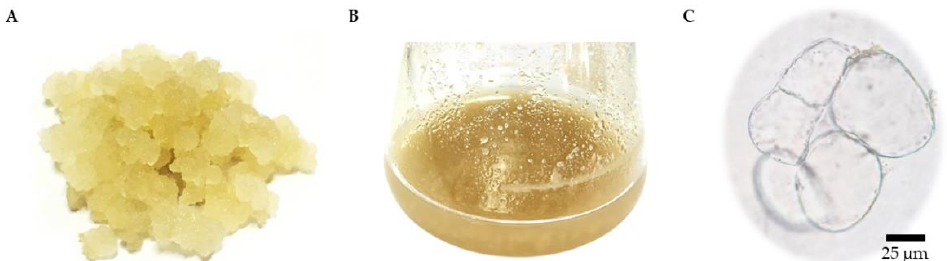
Figure 3. Establishment of R. nasutus cell suspension culture: ( A ) leaf-derived yellow friable callus; ( B ) SCCs of R. nasutus ; ( C ) morphology of 15 day friable callus under a bright-field microscope. The scale bar represents 25 µm.